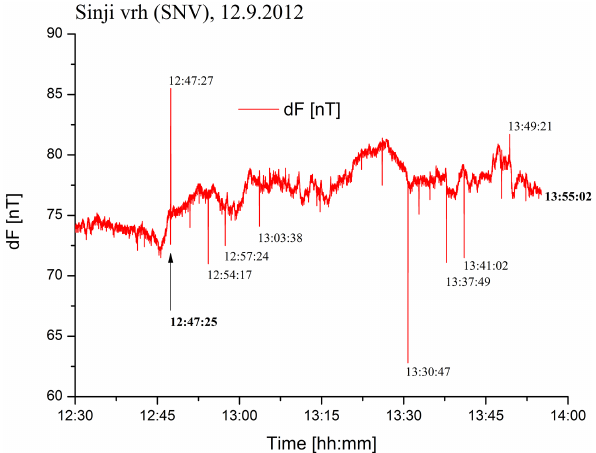
Figure 2. Variations in the geomagnetic field’s absolute values dur- ing the thunderstorm on